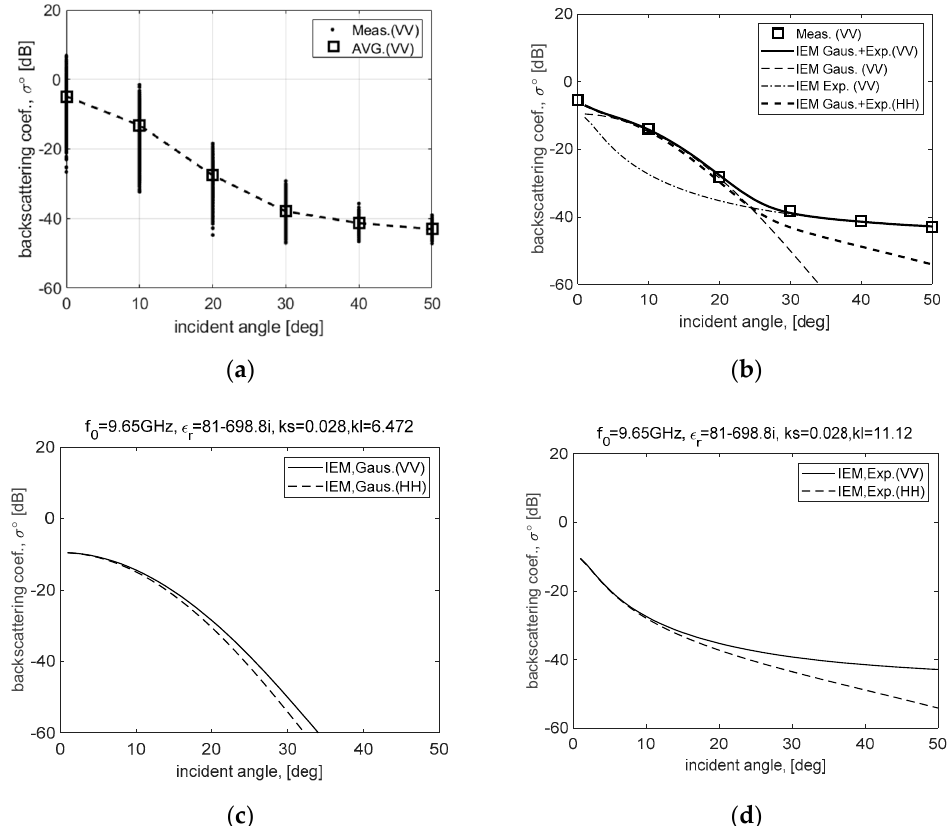
Figure 3. Backscattering coe ffi cients from the sea surface simulated by a theoretical scattering model of an integral equation scattering model (IEM): ( a ) is in situ data measured by the FMCW signal-based scatterometer at the Ieodo ocean research station (Korea Hydrographic and Oceanographic Agency); ( b ) is a composite polarimetric response with two-scale ( c ) Gaussian- and ( d ) exponential-correlated surfaces, (for windy sea surface within about 2 m / s to 4.5 m /